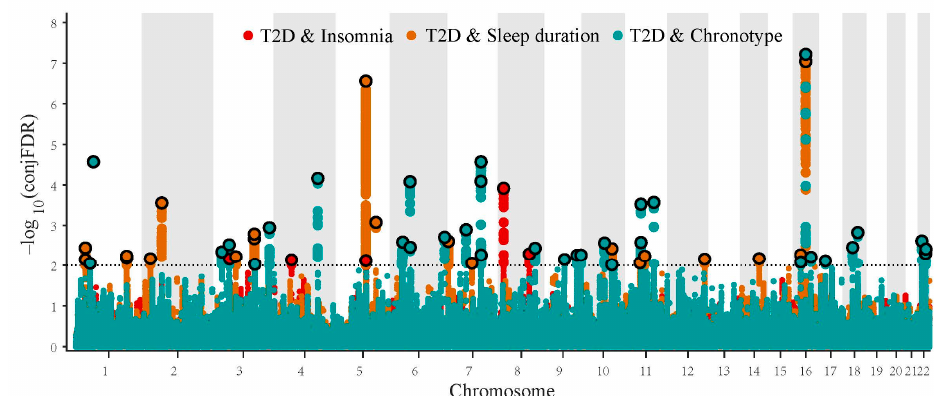
Figure 2. Conjunction FDR Manhattan plot of conjunctional –log10 (FDR) values for type 2 diabetes and insomnia, sleep duration, or chronotype. SNPs with conjunctional FDR < 0.01 (i.e., conjunctional –log10 (FDR) > 2.0) are shown with enlarged data points, whereas the small points represent other SNPs. A black circle around the enlarged data points indicates the most significant SNP in each LD block. The figures show the localization of the “conjunctional loci”, and further details are presented in Table 1. Table 1. Genetic loci with conjunction FDR < 0.01 shared between type 2 diabetes and sleep traits. Locus.No.